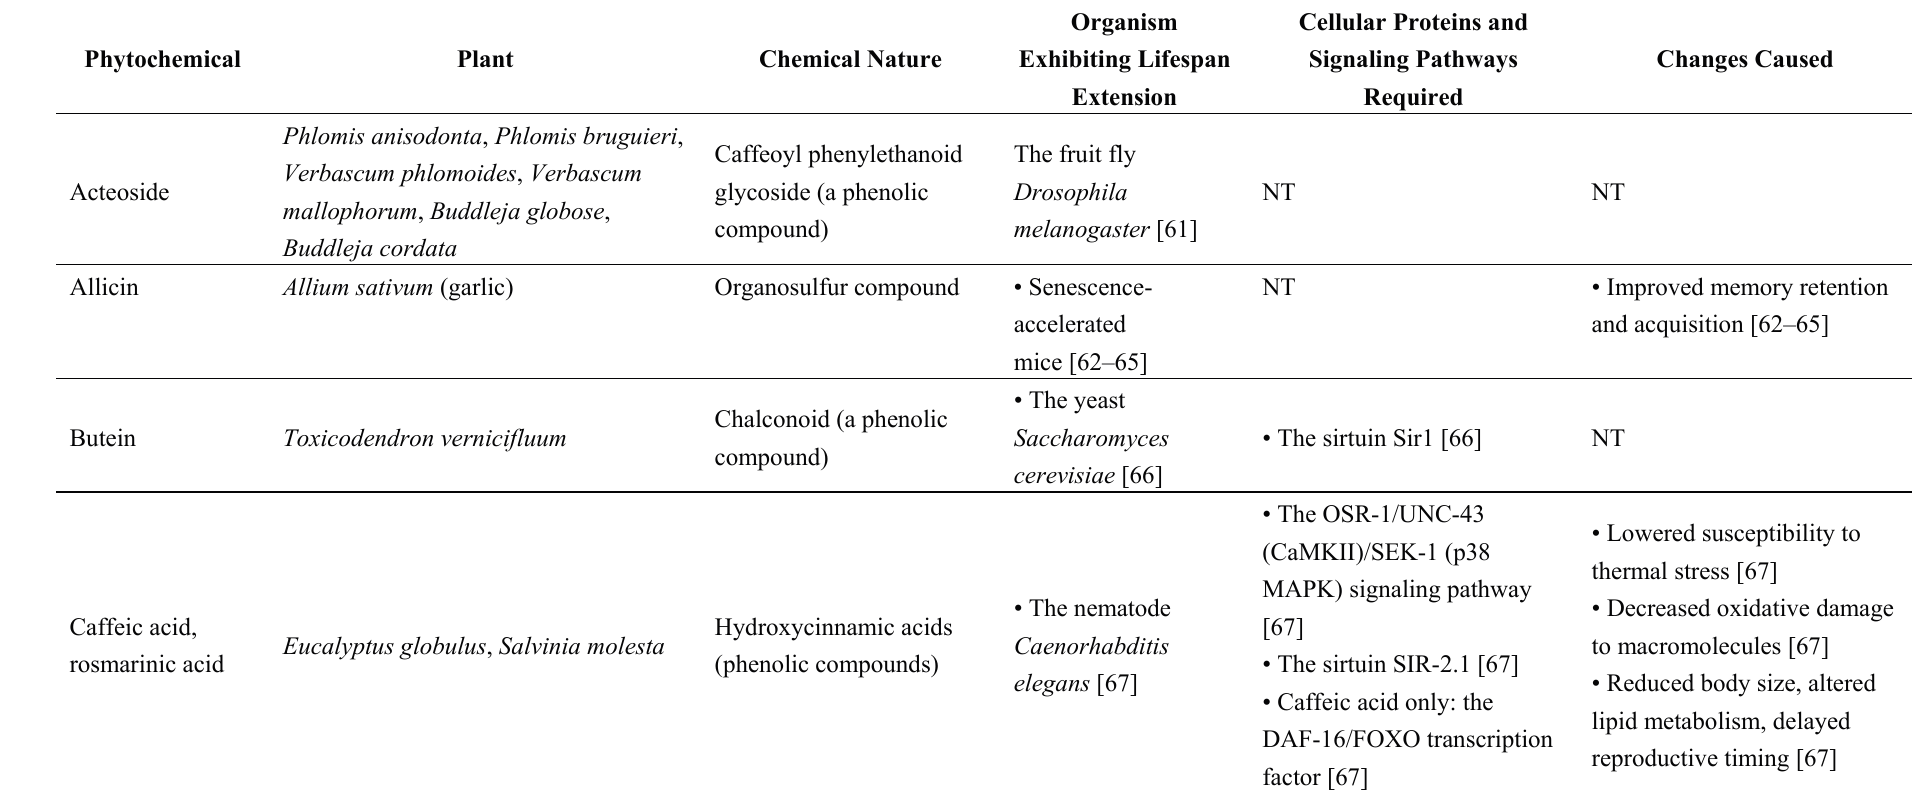
Table 1. Phytochemicals that extend lifespan in various heterotrophic organisms and longevity-defining cellular processes that they modulate. Abbreviations: CaMK, Ca 2+ /calmodulin-dependent protein kinase; FOXO, forkhead box protein O; HDTIC,